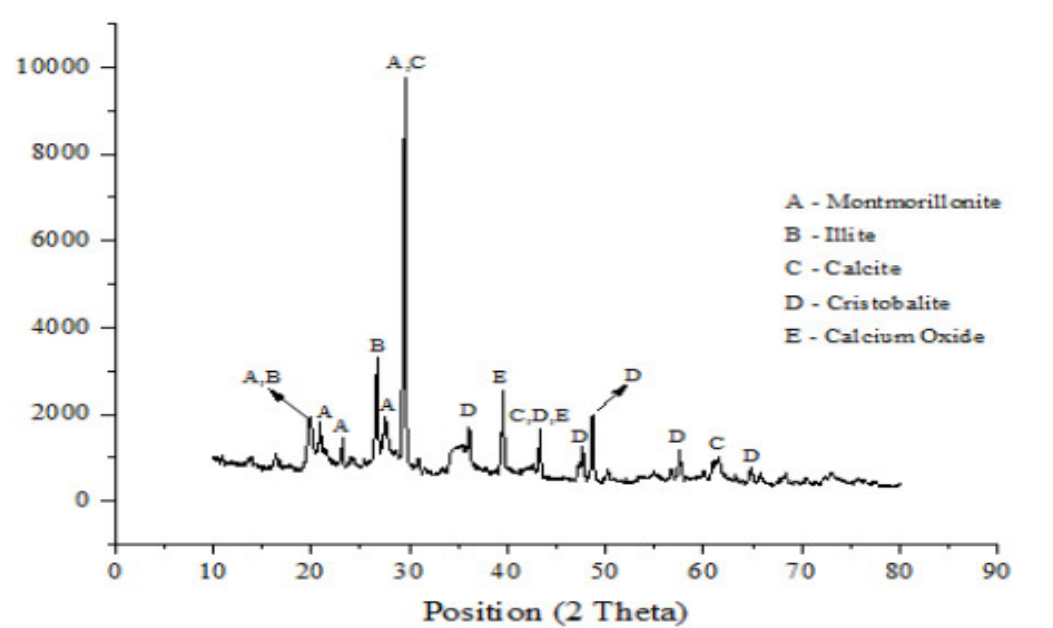
Figure 2. XRD Analysis of bentonite clay [43].